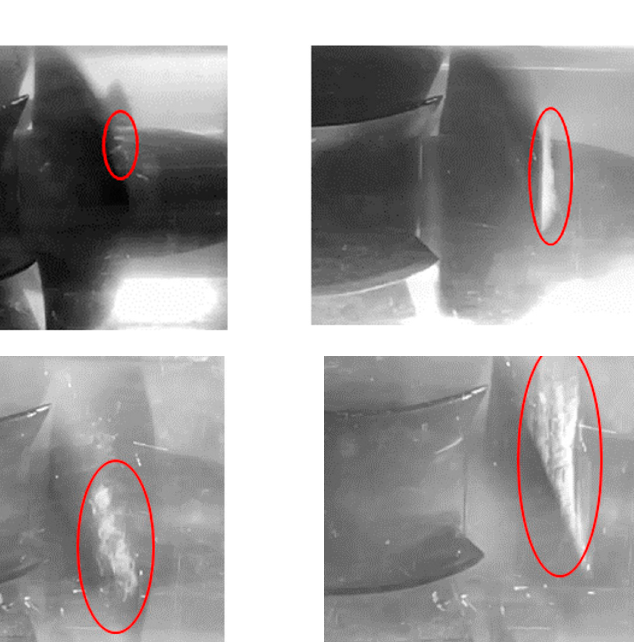
Figure 16. Acceleration scheme 1.